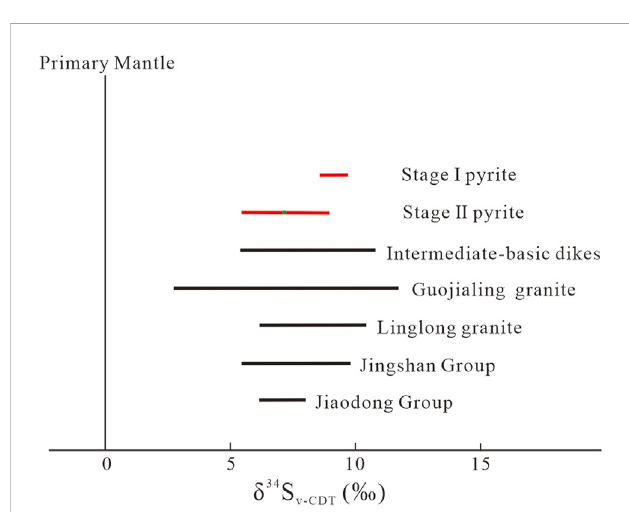
FIGURE 7 Sulfur isotopic compositions of pyrites from the Yangjiakuang gold deposit. The ranges of major geologic units are from Tian et al., 2020; Li et al., 2021; Liu. X. Y et al.,